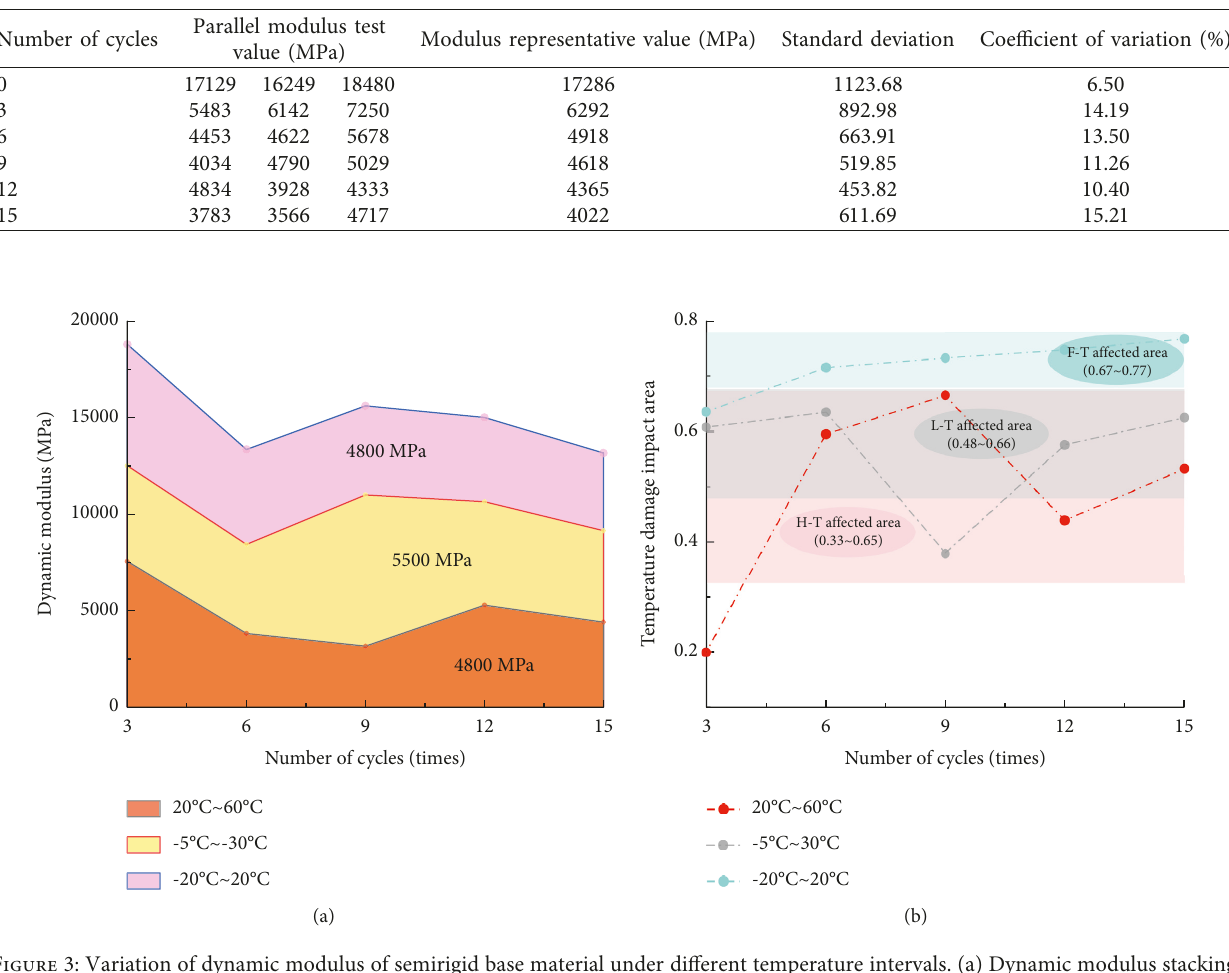
Table 8: Experimental results of dynamic modulus of semirigid base material under the temperature range of